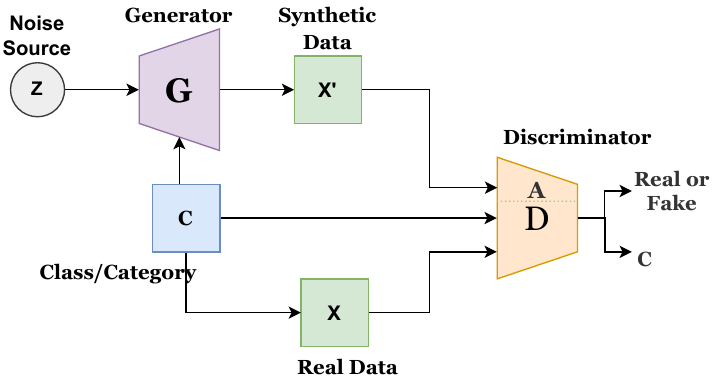
Figure 3. Architecture of proposed improved CGAN model.